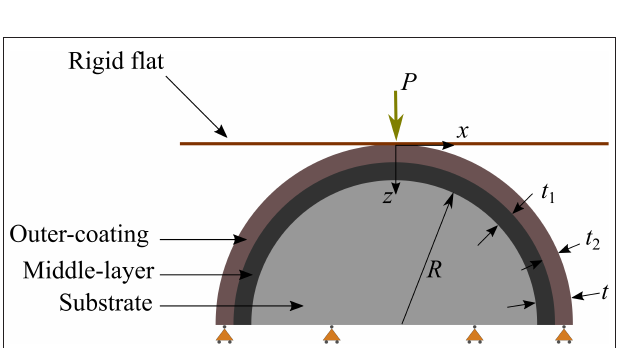
FIGURE 2 | A bilayer coated sphere pressed by a rigid